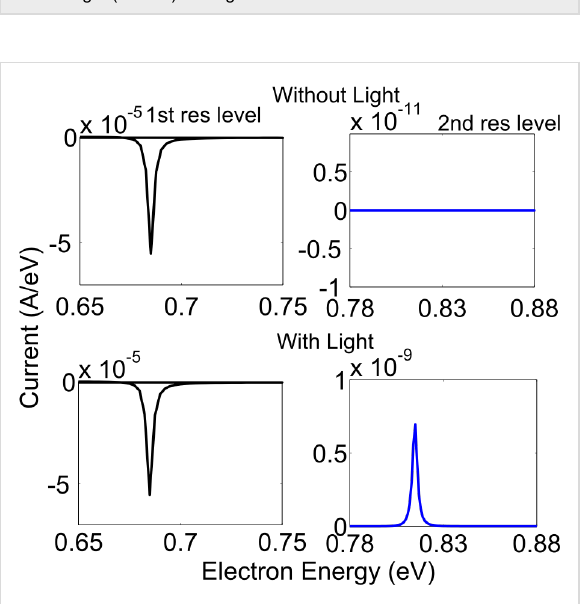
Figure 6: (armchair structure) Current density versus electron energy for light detection by coupling light between two resonant peaks (top) without light (bottom) with light.